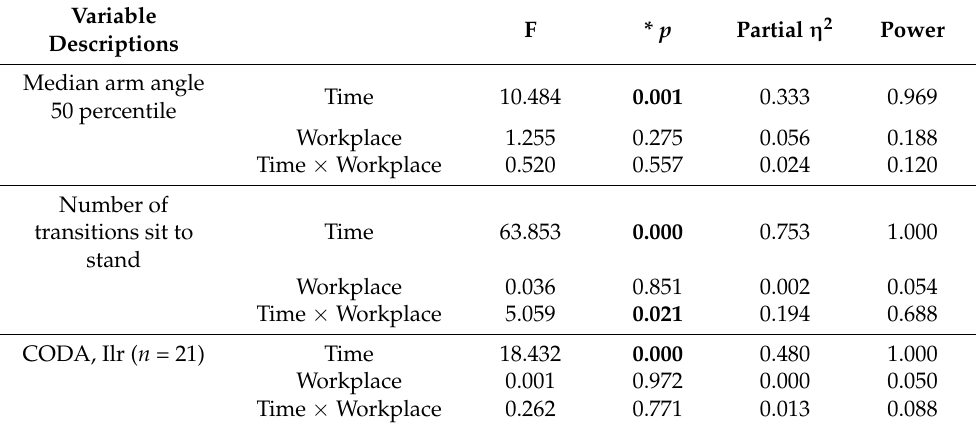
Table 3. The Workplace (telework; office) and Time (leisure time before workhours; work during regular workhours; leisure time after workhours) effects and interaction effect for postures and movements ( n = 23).